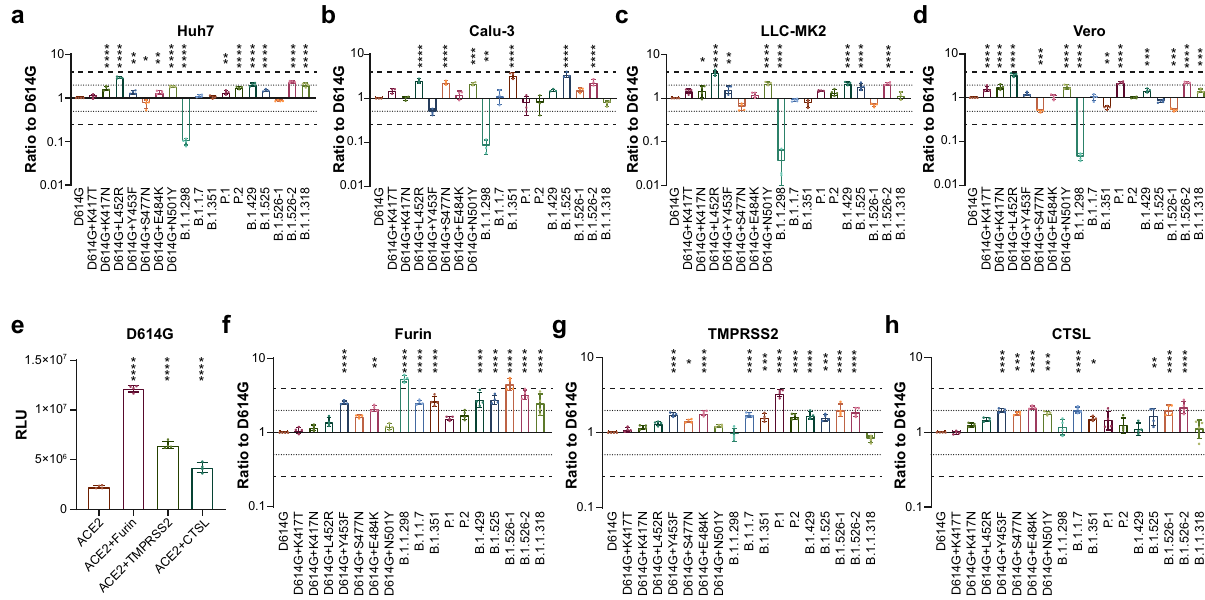
Fig. 2 The infectivity of SARS-CoV-2 Variants in primate cell lines and Furin/TMPRSS2/CTSL expressed 293T-ACE2 cells. a – d SARS-CoV-2- susceptible cells as indicated were used to compare the infectivities among 10 SARS-CoV-2 variants. Pseudostyped virus was quanti fi ed via RT-PCR and all strains were diluted to the same copy number. Cells were harvested 24 h after pseudostyped virus infection and analyzed for luminescence activities (RLUs). Relative infectivities compared with the D614G reference strain are displayed as the RLU ratio to D614G. e – h furin, TMPRSS2, and cathepsin L (CTSL)-stably overexpressing 293T-hACE2 cells were used compared to mock 293T-hACE2 cells. All cells were infected with the same copy number of pseudotyped SARS-CoV-2 variants. Chemiluminescence signals were detected 24 h later. Data shown indicate relative changes in infectivity due to the enzyme overexpression. Relative RLUs were compared with or without the indicated enzyme fi rst, and then compared with the D614G reference strain. e RLU of cells infected with D614G virus. f – h Ratios by which enzyme overexpression induced enhanced infection, compared with D614G. The results were obtained from four independent experiments and the values shown indicate means± SEMs. Dashed/dotted lines indicate the threshold of fourfold/twofold difference. Asterisks indicate statistical signi fi